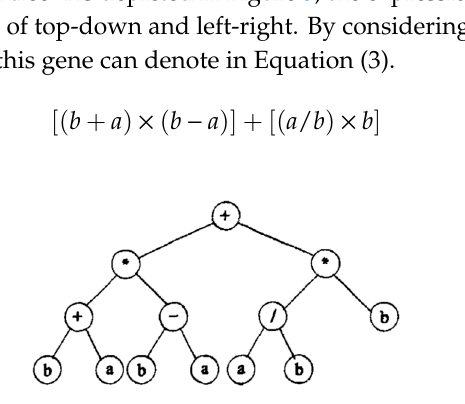
Table 2. The construction of a chromosome.